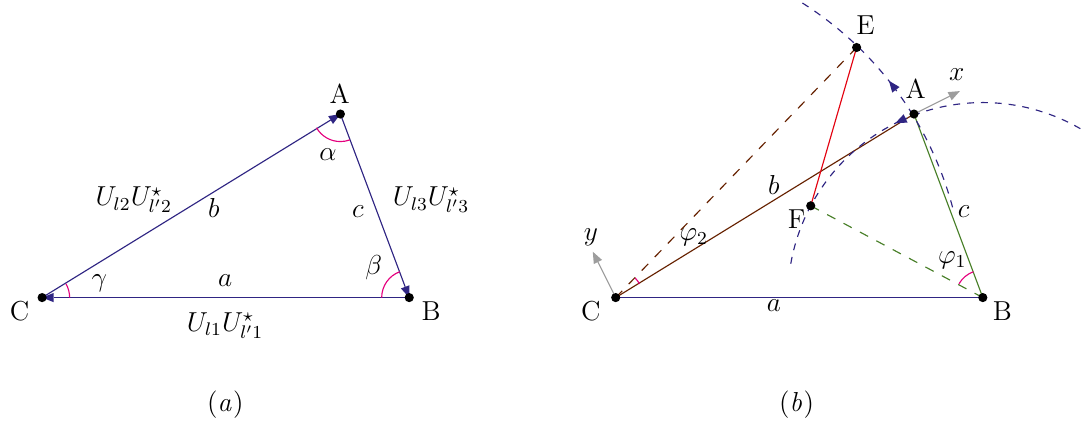
Figure 1 . (a) Unitarity triangle with the sides ( a, b, c ) and angles ( α, β, γ ) . (b) Modification of the unitarity triangle due to neutrino propagation (adapted from